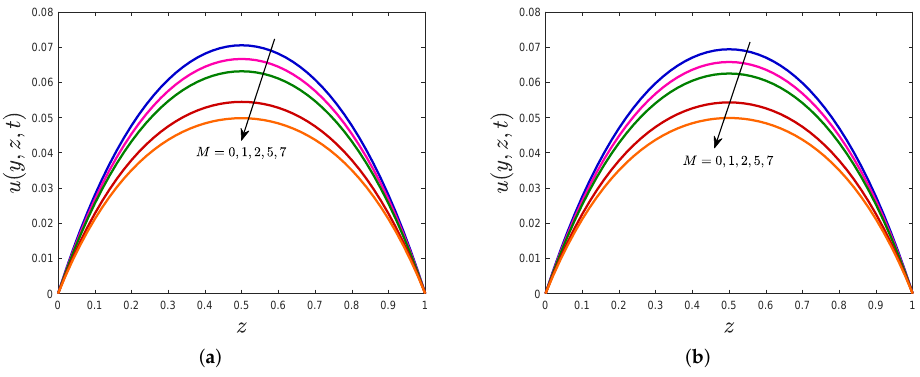
Figure 11. One-dimensional velocity profile for various values of M . ( a ) Maxwell fluid, ( b ) Newtonian fluid.